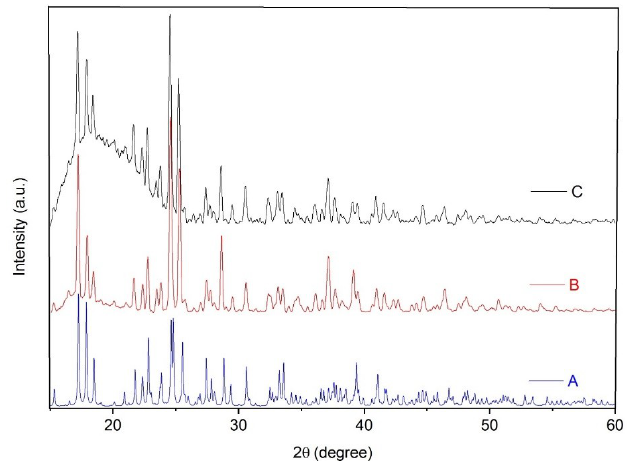
Figure 5. Powder X-ray diffraction patterns of coordination polymer 1 : ( A ) simulated from single crystal